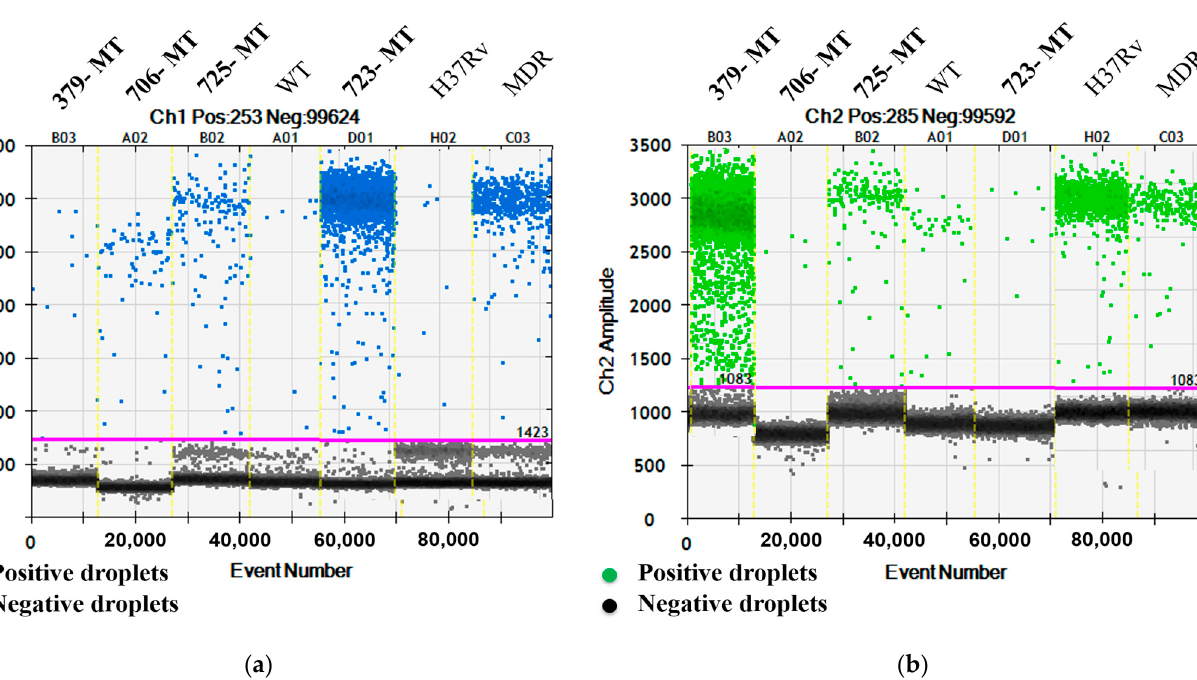
Figure 1. One D amplitude of ( a ) channel 1, FAM; ( b ) channel 2, HEX signals detecting MT and WT, respectively, of katG gene at codon 315 using mutation detection assay for katG S315T. The FAM (MT) signals for the LOD of the rpoB S531L assay were observed to be 1 ng, 100 pg, 10 pg, 1 pg, 100 fg, 10 fg, and 1 fg; and the positive controls were 371,391.3, 37,139.1,